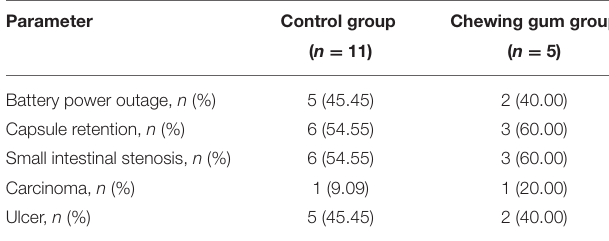
TABLE 4 | Reasons for non-completion of capsule endoscopy